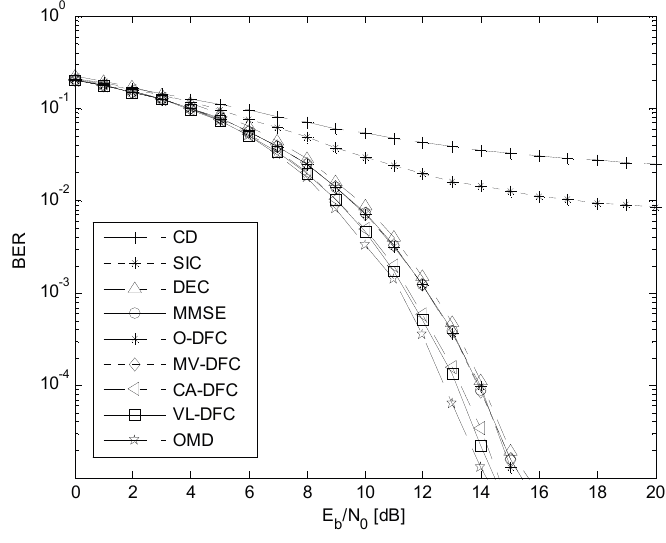
Figure 9. The BER versus E b / N 0 curves in multipath channel when K =